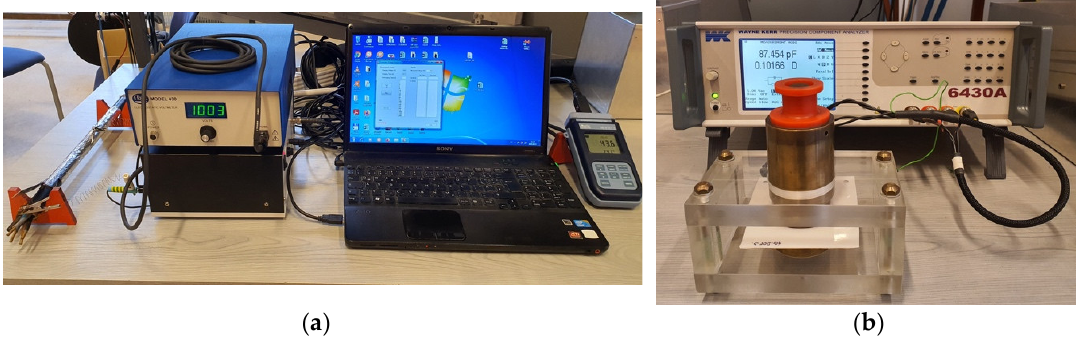
Figure 5. Measurement of dielectric properties: ( a ) voltage response measurement on a PVC cable sample; ( b ) measurement of PVC films by cylindrical copper electrodes by Wayne–Kerr 6430A impedance analyzer.